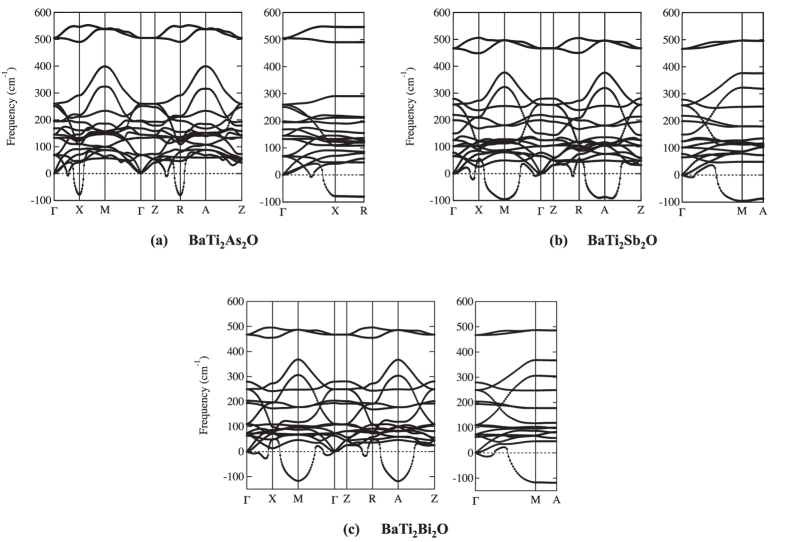
Phonon dispersions of BaTi2Pn2O under P4/mmm symmetry (Pn = (a) As, (b) Sb, and (c) Bi).